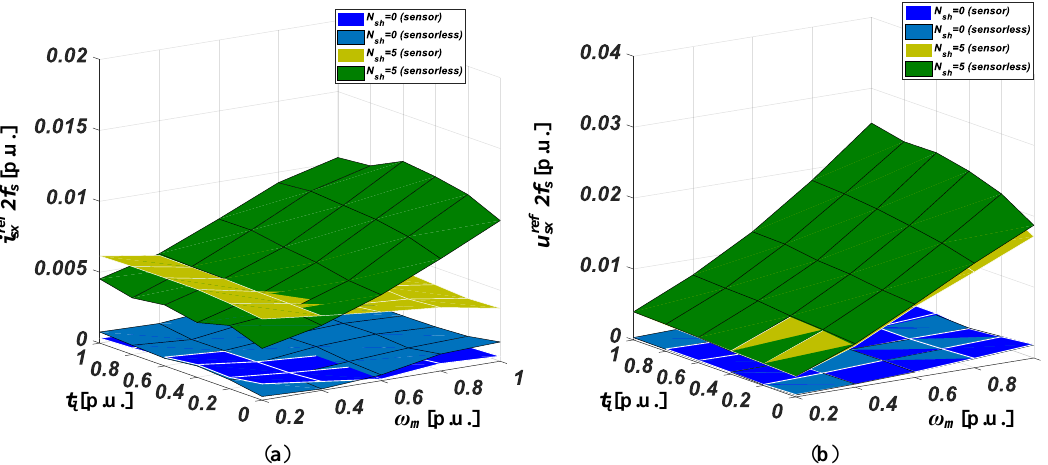
Figure 15. Comparison between the operation with speed-sensor and speed-sensorless operations for the f sh frequency amplitude of reference ( a ) field-producing current and ( b ) field-producing voltage.